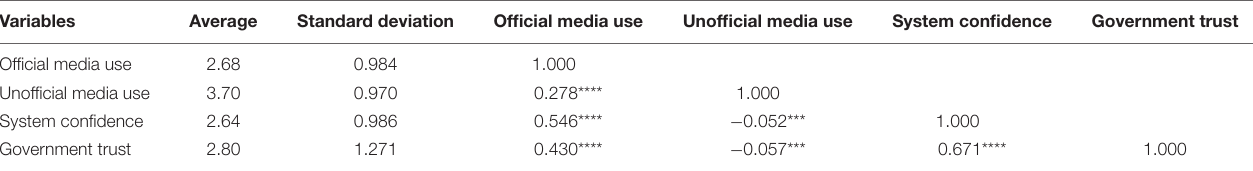
TABLE 3 | Descriptive statistics and correlation matrix of latent